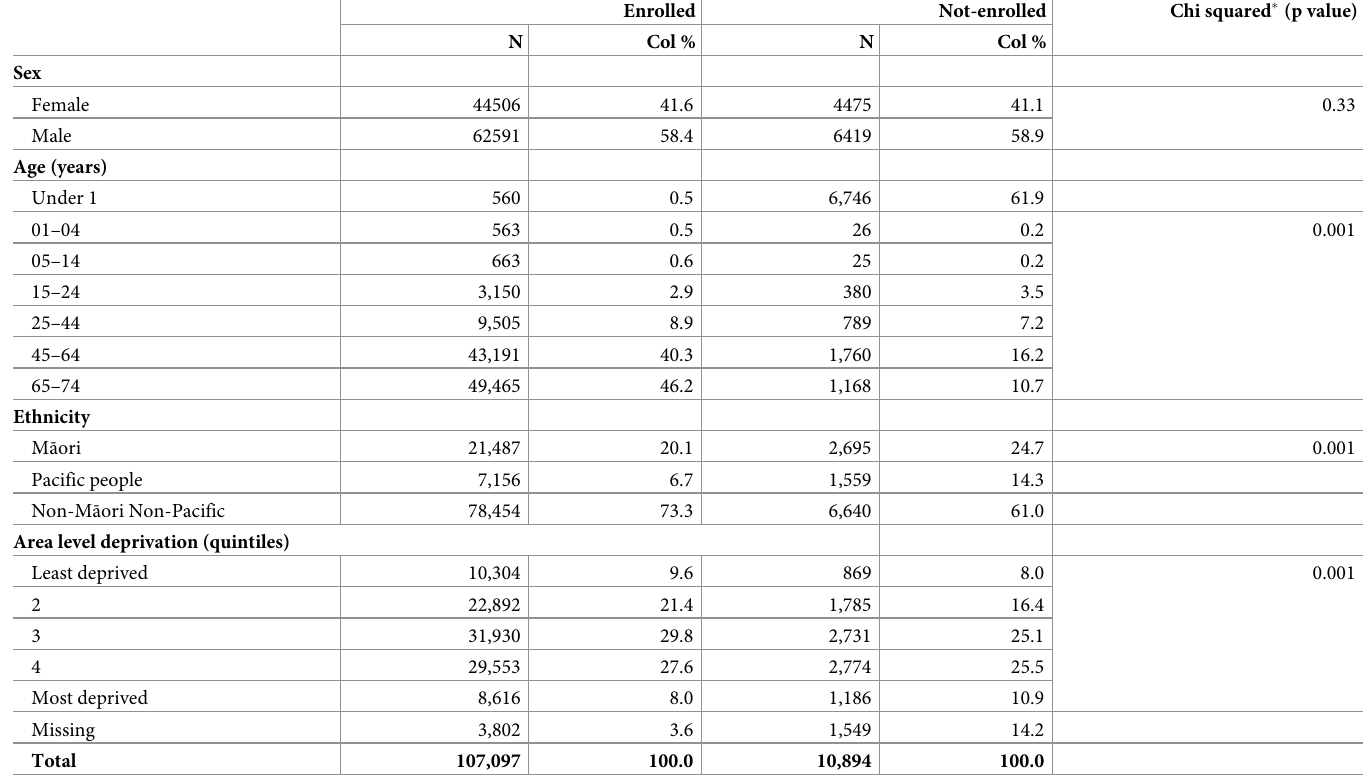
Table 2. Socio-demographic characteristics of the study population (premature deaths) by enrolment